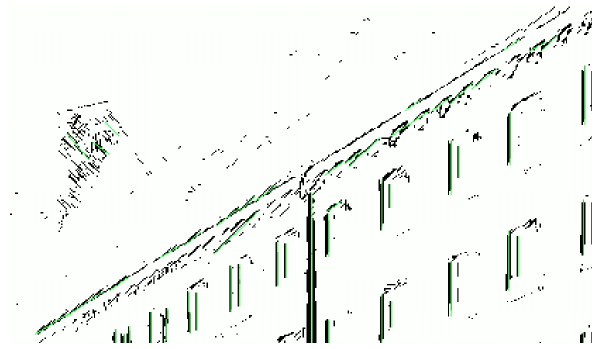
Figure 10: Detail image of the right wall of building H¨ulssebau. Green lines point to the results after application of the regression task.